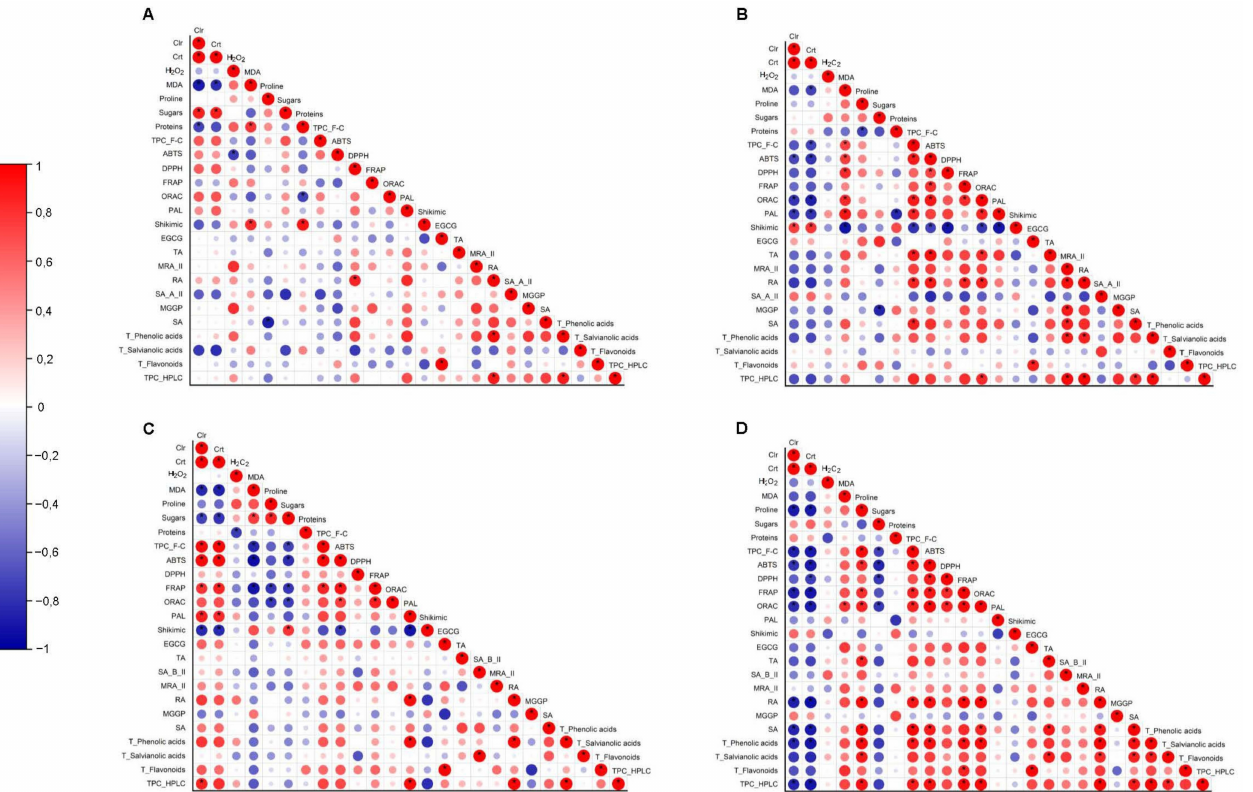
Figure 5. Heat map corresponding to the Pearson’s correlation coefficients (circles) between the contents photosynthetic pigments (chlorophylls and carotenoids), oxidative stress indicators (H 2 O 2 and MDA), osmoprotectants (proline, soluble sugars, soluble proteins), shikimic/phenylpropanoid intermediates (PAL activity, shikimic acid content), total phenolic content (F-C and HPLC), total phenolic acids content (HPLC), total salvianolic acids content (HPLC), total flavonoids content (HPLC), and the most abundant individual phenolic compounds (HPLC), namely epigallocatechin gallate (EGCG), theaflavic acid (TA), salvianolic acid B isomer II (SA_B_II), methylrosmarinic acid isomer II (MRA_II), rosmarinic acid (RA), salvianolic acid A isomer II (SA_A_II), methyl 6-O-galloyl- β -D-glucopyranoside (MGGP), and sagerinic acid (SA) and antioxidant activity (DPPH, ABTS, FRAP, ORAC) from T. lotocephalus ( A ) in vitro cultures; ( B ) micropropagated plants; L. viridis ( C ) in vitro cultures; ( D ) and micropropagated plants. * Correlation is significant ( p ≤